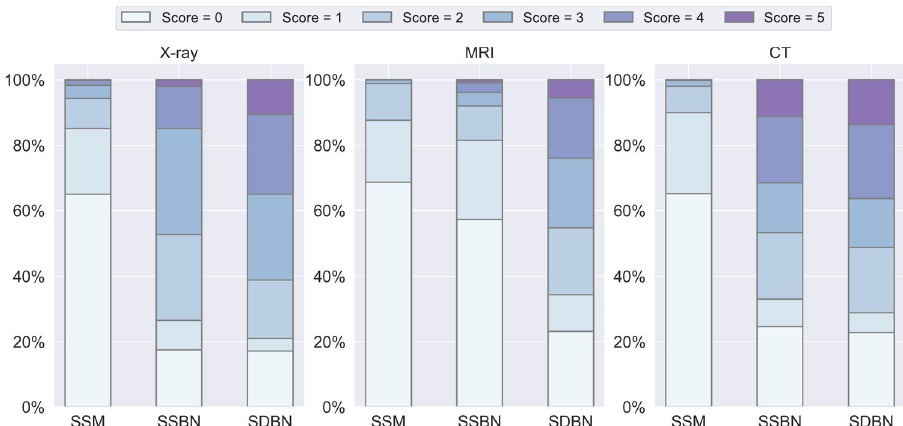
Fig. 5 Adversarially trained neural network with dual batch norm yields clinically interpretable saliency maps. Figure shows the assessment of diagnostic relevance in percentage for SSM, SSBN, and SDBN models as evaluated independently by six radiologists. Each color bar reveals percentage of gradient saliencies with same rating score.